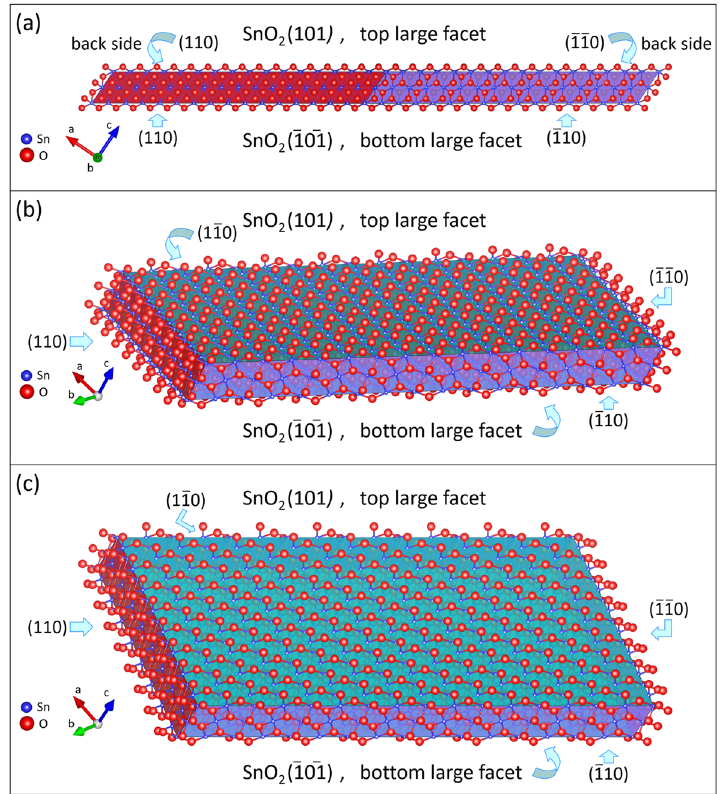
Figure 12. ( a ) Model of the SnO 2 nanosheet with large (101) and (− 10− 1) facets. ( b , c ) Tilted images of the SnO 2 nanosheet. Calculations were performed using the VESTA program 25 and crystal structure data of SnO 2 (COD ID:1000062) 26